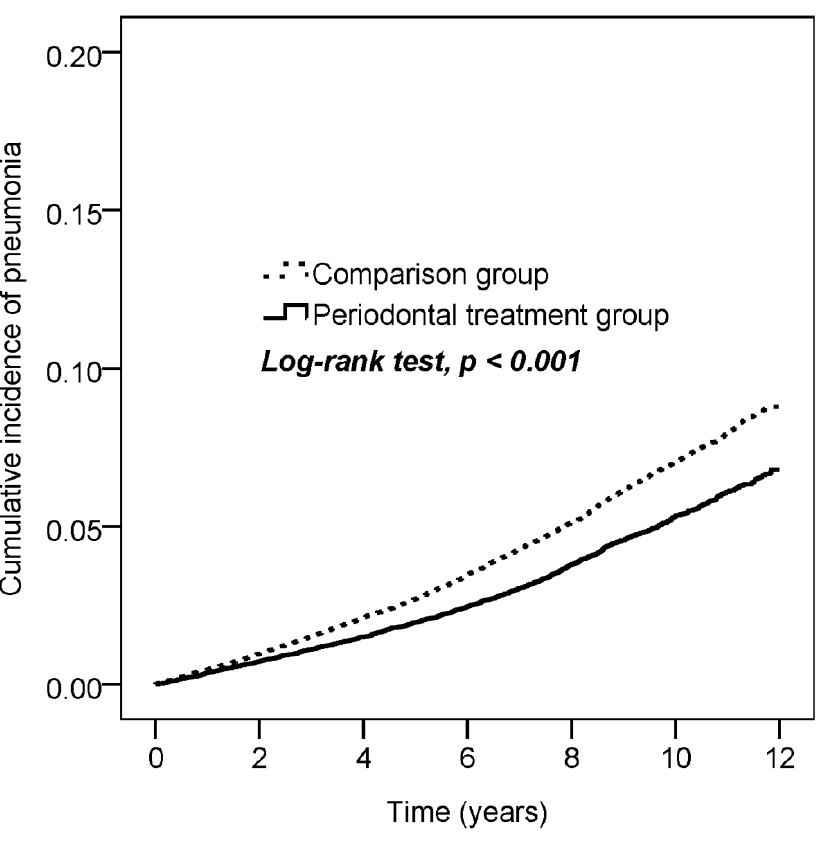
Figure 2. Kaplan–Meier plot for the cumulative incidence of pneumonia in the periodontal treatment group and comparison group used in this cohort study.